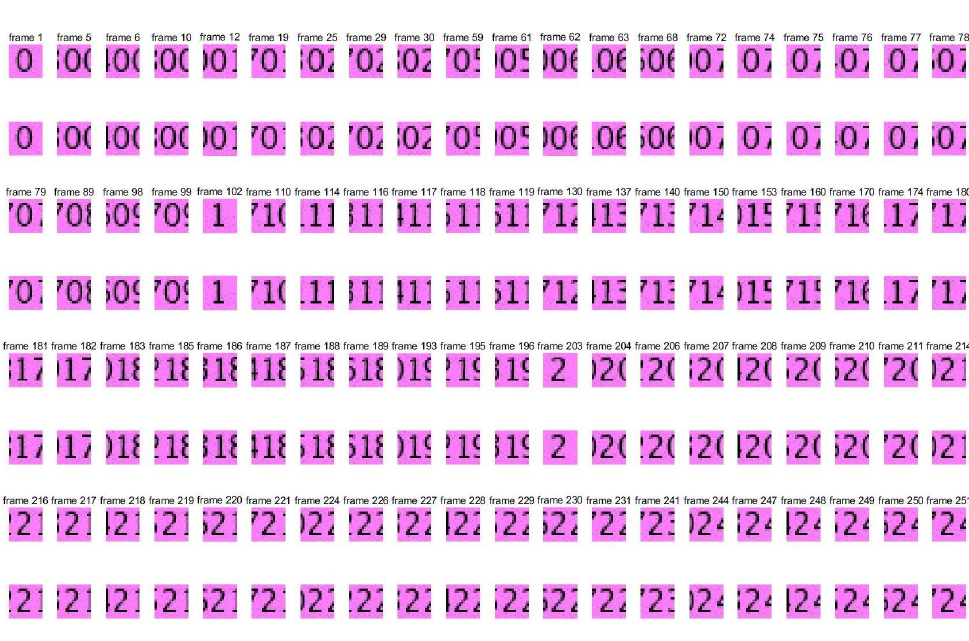
Figure 3. Pictures of watermark 2 and extracted watermark 2. Pictures in the first, third, and fifth lines are the frames in the original watermark video 2, and pictures in the second, fourth, and sixth lines are the frames in the extracted watermark video